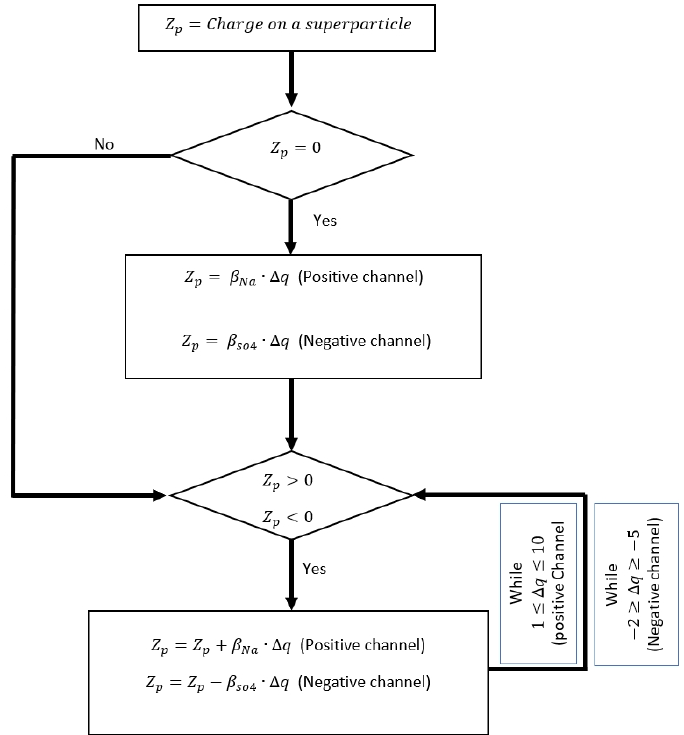
Figure 4. Initialization of SP charge distribution based on the defined model.